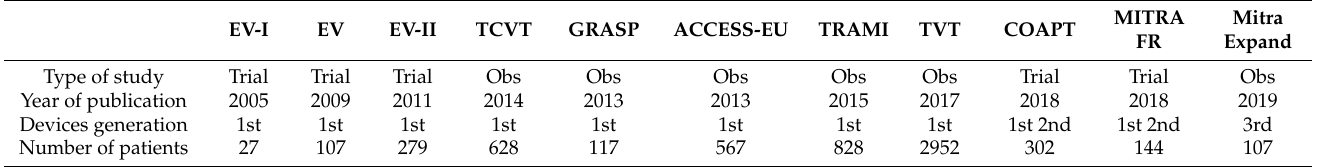
Table 1. Complications during and after MitraClip